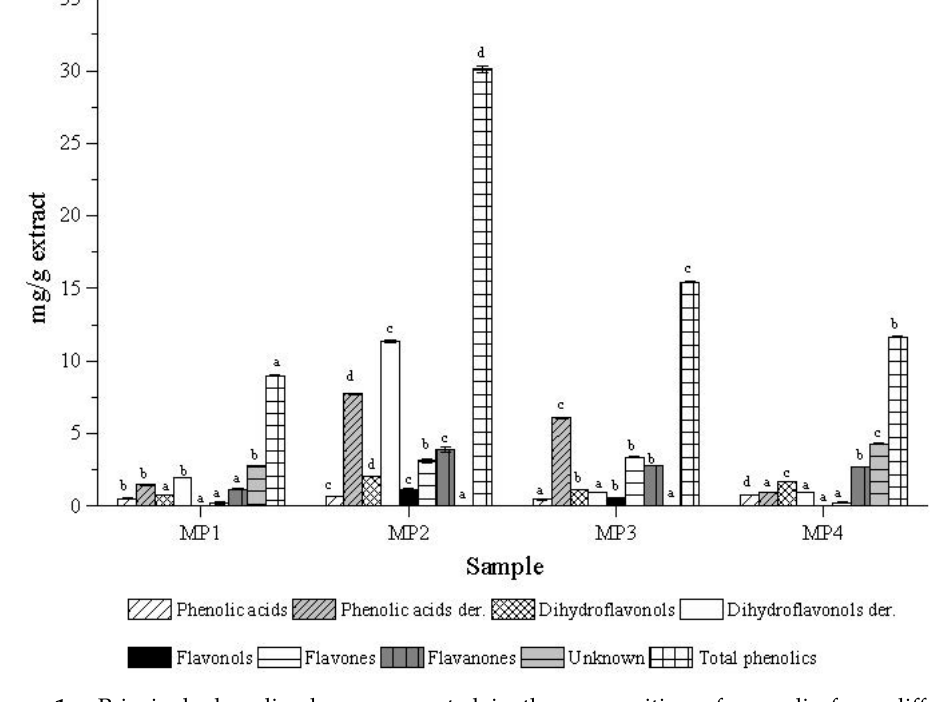
Figure 1. Principal phenolic classes presented in the composition of propolis from different Morocco